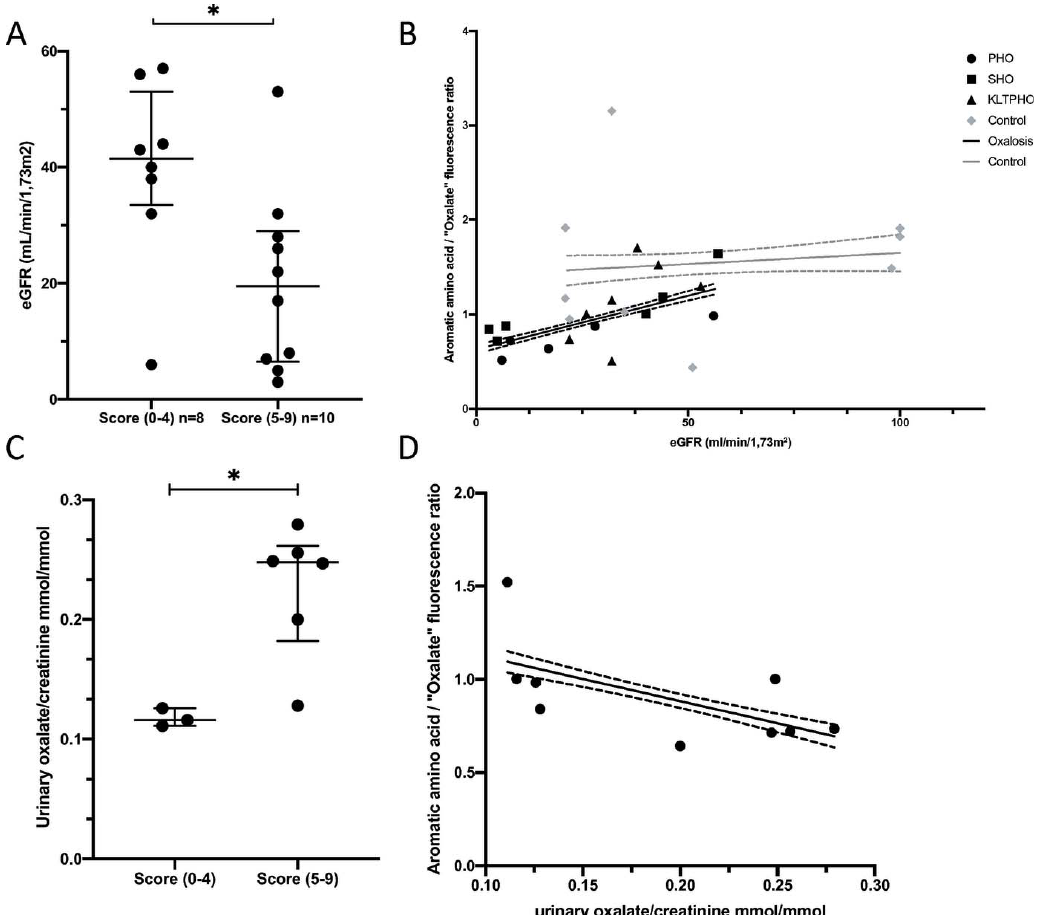
Figure 7 eGFR and oxaluria correlation with WFUV oxalate imaging. (A) In oxalosis patients, a higher nine-point oxalosis histological score is associated with lower eGFR. (B) In oxalosis patients, a lower ‘aromatic amino acid’/ ‘oxalate’ tubular fluorescence ratio is associated with lower eGFR (linear regression: black line; dashed line IC95, p < 0.0001) whereas in control patients both variable are independents (linear regression: grey line; dashed line IC95). (C) In oxalosis patients, higher nine-points oxalosis histological score is associated with higher urinary oxalate/creatinine ratio. (D) High urinary oxalate/ creatinine ratio is associated with lower ‘aromatic amino acid’/ ‘oxalate’ tubular fluorescence ratio (linear regression: black line; dashed line IC95, p < 0.0001). Median with 25–75 interquartile range. * p <